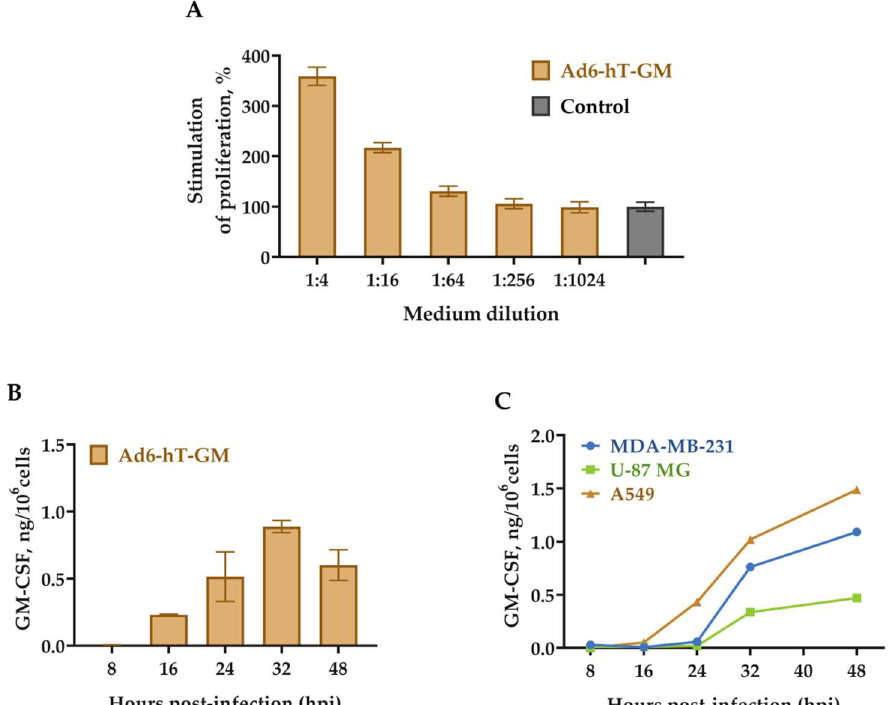
Figure 3. GM-CSF production by Ad6-hT-GM-infected cells. ( A ) Stimulation of TF-1 cells proliferation by GM-CSF. A549 cells were infected with Ad6-hT-GM at MOI = 100 vp/cell, supernatant was collected after 48 h. Supernatant collected from mock-infected cells was used as a control. Stimulation of TF-1 cells proliferation was determined by XTT assay following a 72 h incubation. Data from the mock-infected group was normalized to 100%. Data are presented as mean ± SD ( n = 3). ( B ) Dynamic of GM-CSF expression in A549 cells. Cells were infected with Ad6-hT-GM (MOI = 100 vp/cell); at various time points, infected cells were incubated with fresh medium for 1 h before collection and measured for GM-CSF concentration by ELISA. Data are presented as mean ± SD (n = 3). ( C ) Dynamic of GM-CSF production in various Ad6-hT-GM-infected cell lines. A549, MDA-MB-231, and U-87 MG cells were infected with MOI = 100 vp/cell; medium was collected, and GM-CSF concentration was measured by ELISA.